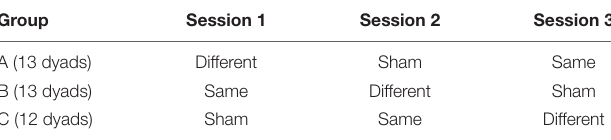
TABLE 1 | Organization of different stimulation types across